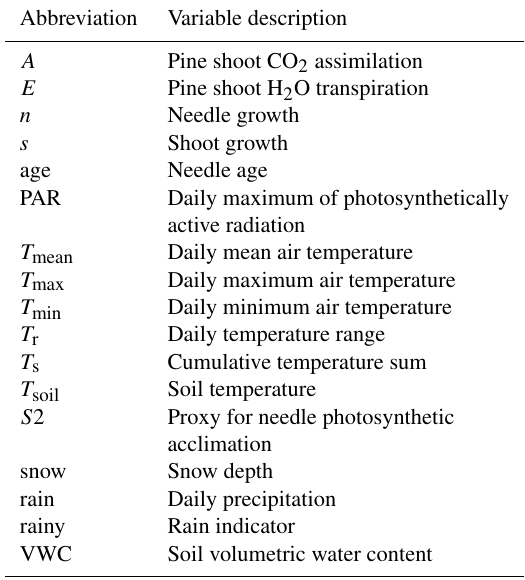
Table 2. The variables used in